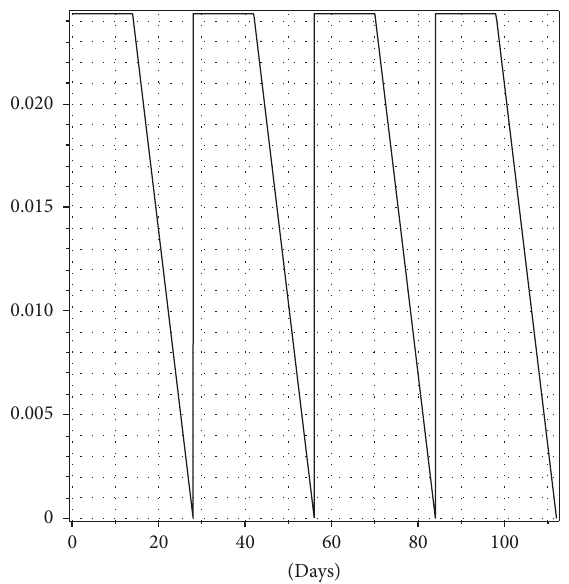
Figure 8: Biweekly fumigation